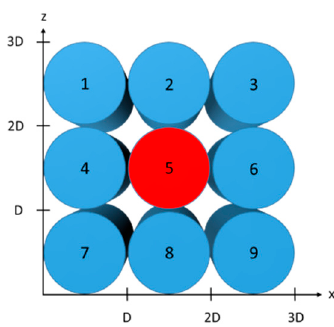
Figure 7. Thermal runaway initiation in the middle cell of the battery module. D is the battery diameter.